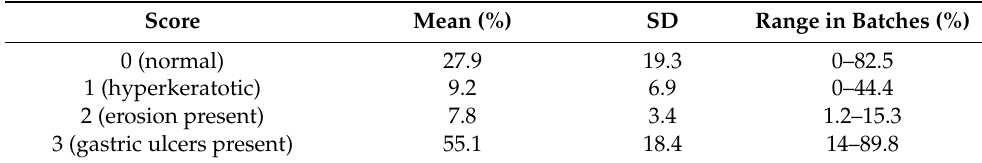
Table 1. Herd-level prevalence of different stomach scores ( n of observations = 360). Score Mean (%) SD Range in Batches (%) 0